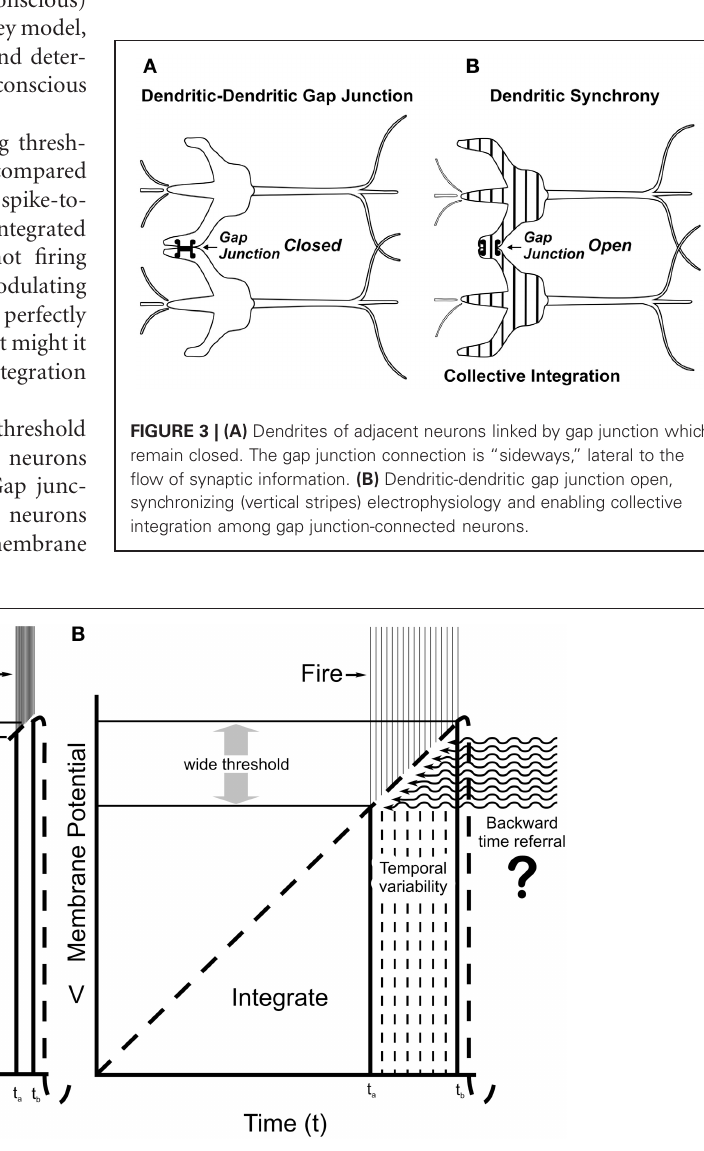
(Naundorf et al., 2006) show a large variability in effective firing threshold and timing. Some unknown “x-factor” (related to consciousness?) exerts causal influence on firing and behavior. Here, quantum temporal non-locality results in backward time referral, suggested as the “x-factor” modulating firing